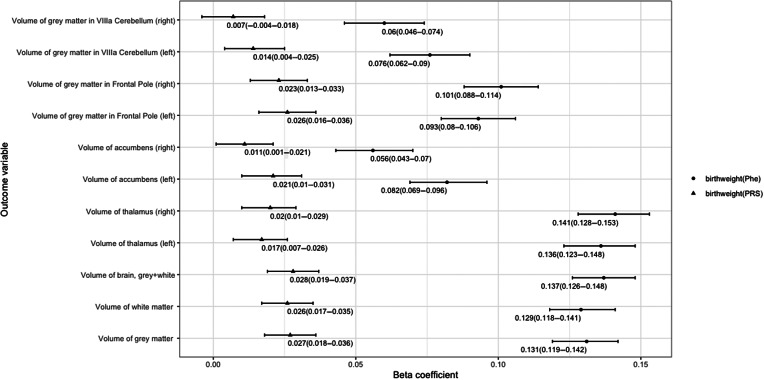
Associations between birth weight and brain volume. The x-axis refers to beta coefficient. The y-axis represents the outcome variables. Points display the beta and 95% confidence intervals (CIs) (error bars) of beta coefficient. Birth weight polygenic risk scores (PRS) indicates the polygenic scores for birth weight. Birth weight phenotype means the phenotype of birth weight. Detail information is showed in Table S2 in the Supplementary Material.